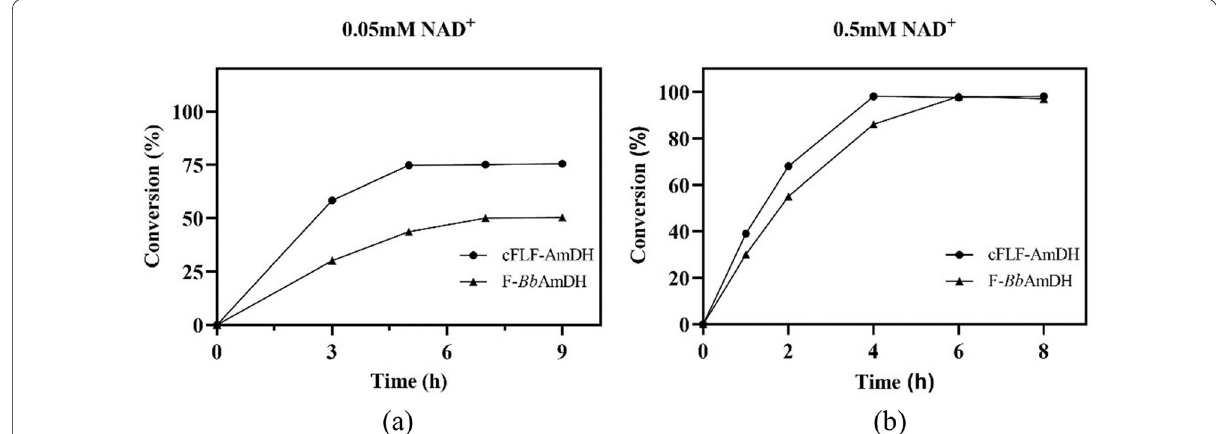
Fig. 5 Effect of NAD + concentration on the reductive amination of pFPA. a 0.05 mM NAD + ; b 0.5 mM NAD + . Reaction conditions: pFPA (0.2 M),